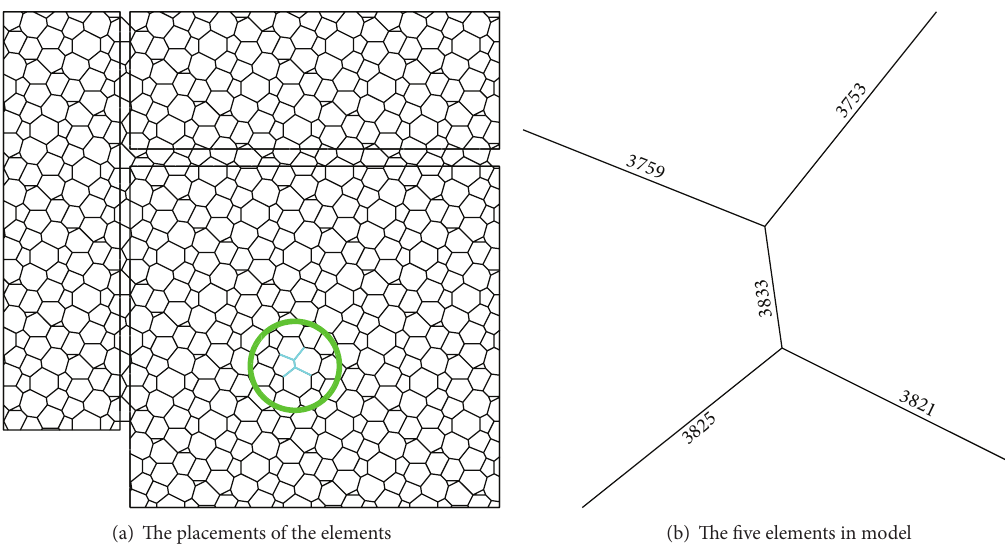
Figure 5: The placements of the five damaged elements.